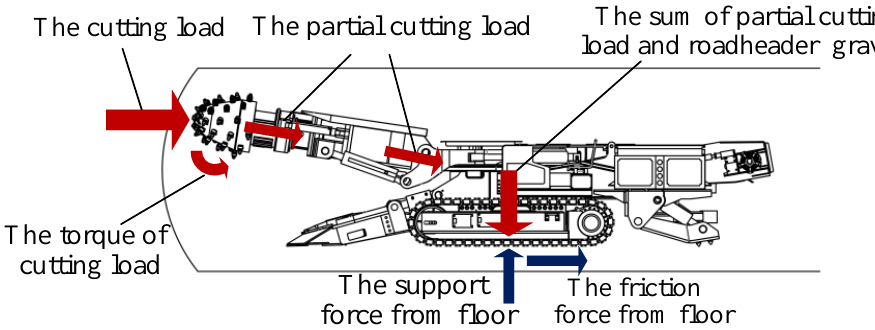
Figure 2. Force analysis diagram of the roadheader. The initial cutting process is that selecting a starting point on the cross-section of the roadway, then the roadheader moves, driving the cutting head to drill into the coal wall to a certain depth. Driven by the telescopic cylinder, the cutting head moves along the cutting path, as shown in Figure 3, until the cutting of the whole section is completed. When the cutting head cuts along the horizontal or vertical direction, the force conditions are similar, and all are subjected to cutting resistance, advancing resistance, and lateral resistance caused by part or all of the cutting load.